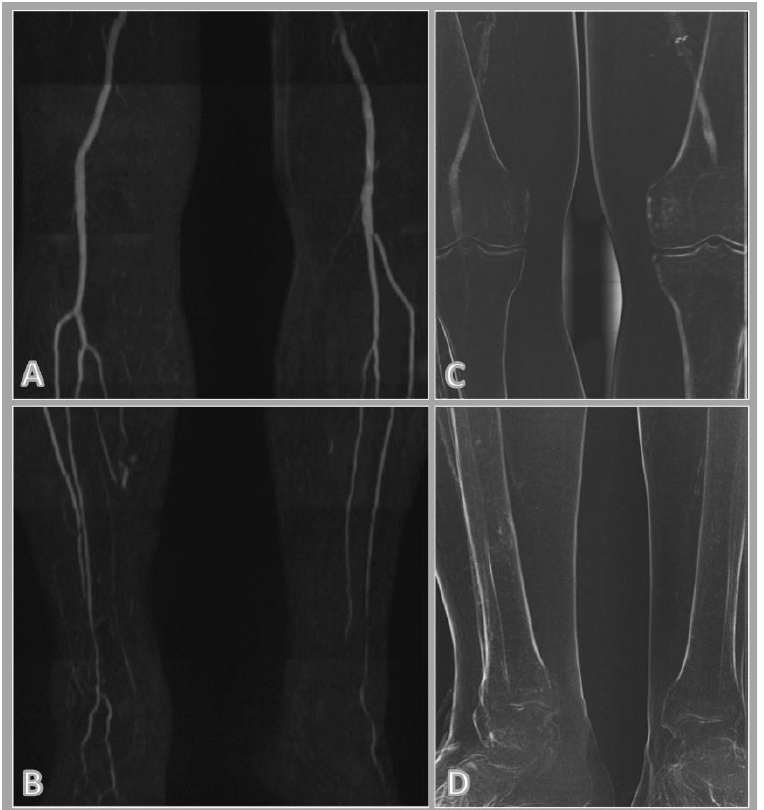
Figure 2. Corresponding quiescent-interval single-shot magnetic resonance angiography (QISS MRA; ( A , B )) and carbon-dioxide digital subtraction angiography (CO2 DSA; ( C , D )) images of the popliteal and crural region. CO2 DSA is compromised by the decreased arterial flow resulting in CO2 not reaching the crural vessels, whereas QISS MRA shows patent popliteal and peroneal arteries ( A , B ).